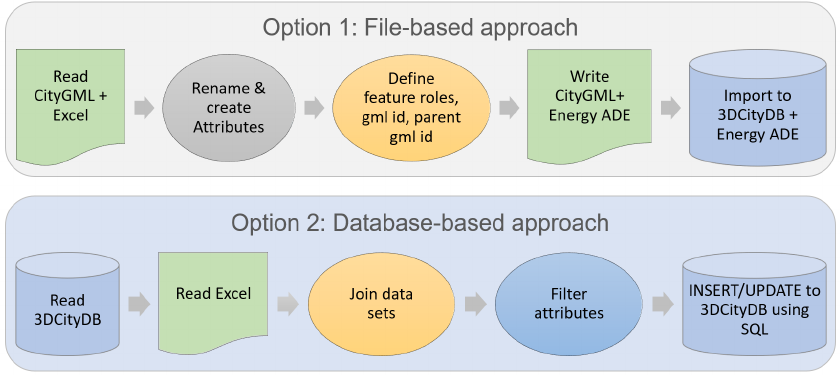
Figure 3. Principles of the Energy Application Domain Extension (ADE) integration